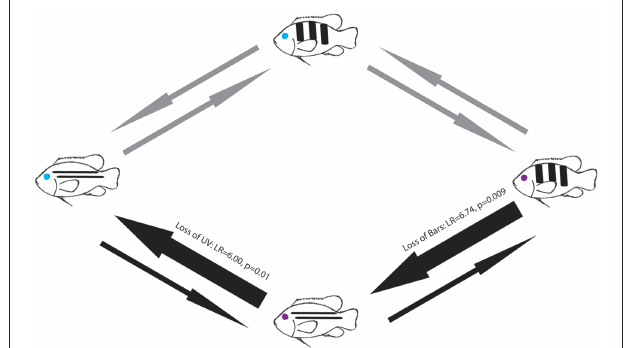
FIGURE 5 | Evolutionary transitions among SWS sensitivity and color pattern character states in Lake Malawi cichlids. Black arrows: likely transitions; statistically significant transitions are indicated by the thick arrows and p -values indicated above arrows. Gray arrows: highly unlikely transitions. Violet eyes: UV-sensitive; blue eyes: non-UV-sensitive. Notice that the likely ancestral state of the Lake Malawi cichlids is a UV-sensitive, barred species, descendants of which would subsequently lose both a barred color pattern and UV sensitivity during the radiation of these fishes.